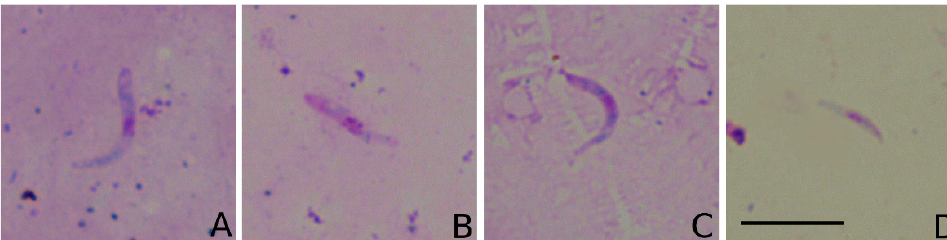
Figure 2. Sporozoites of Haemoproteus asymmetricus cytochrome b lineage TUPHI01 ( A , C ), H. fringillae CCF3 ( B ) in Culicoides segnis , and H. minutus TURDUS2 in Culicoides kibunensis ( D ) in salivary gland preparations. Scale bar: 10 μ m. Methanol-fixed and Giemsa-stained.